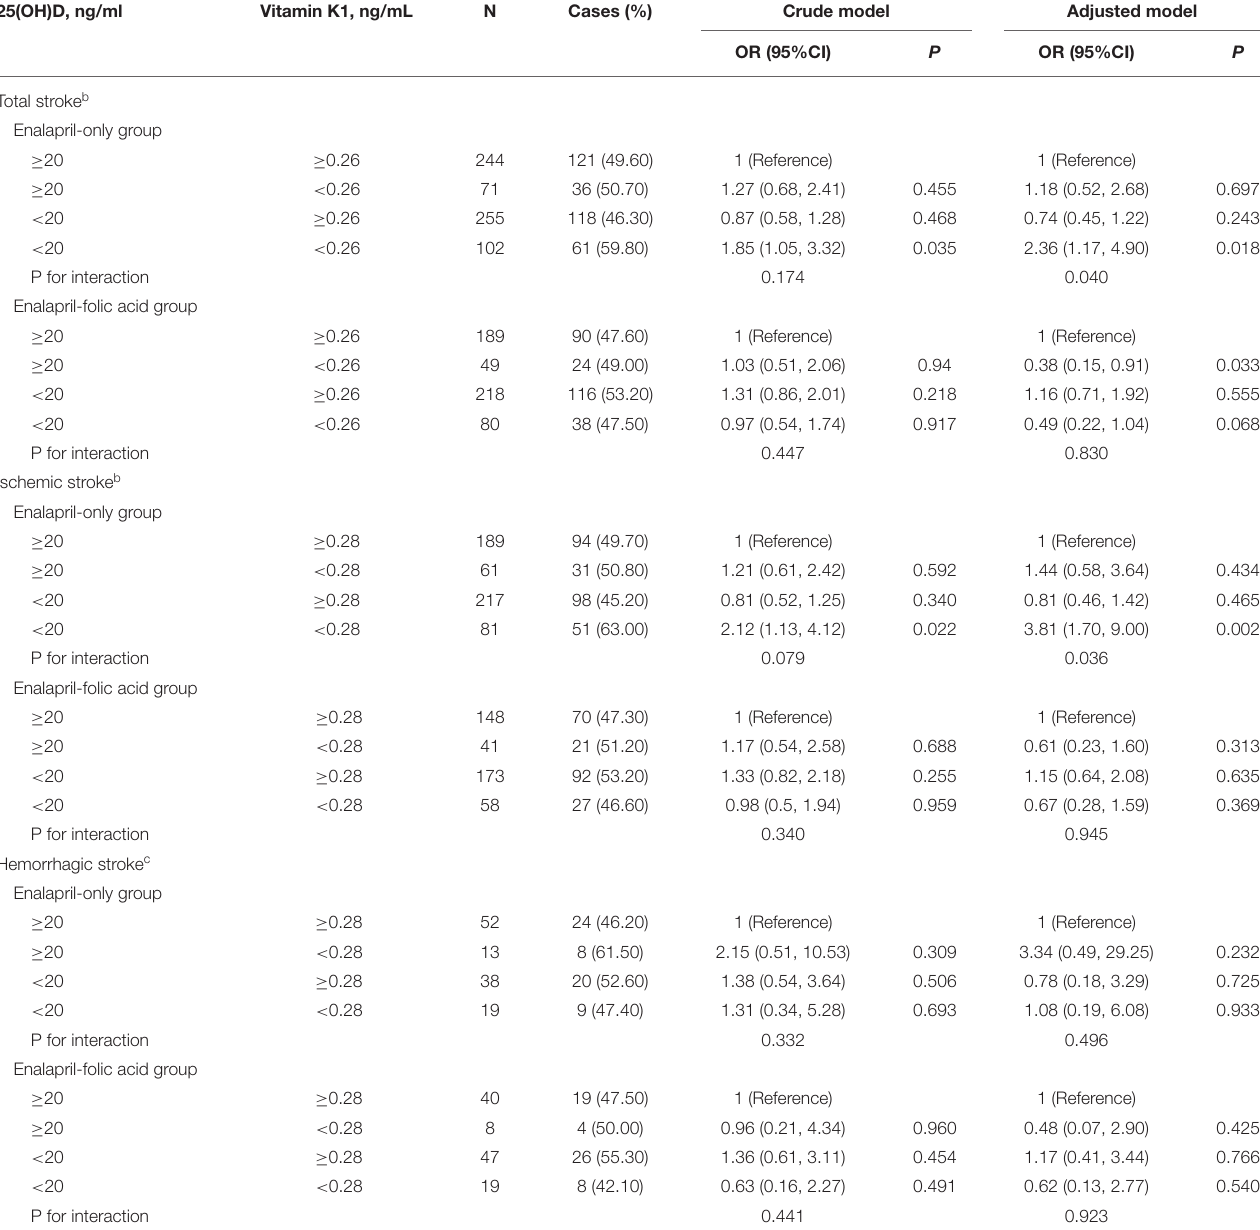
TABLE 4 | The association of plasma vitamin K1 and 25 hydroxyvitamin D [25(OH)D] status with stroke (total and subtypes) a . 25(OH)D, ng/ml Vitamin K1,